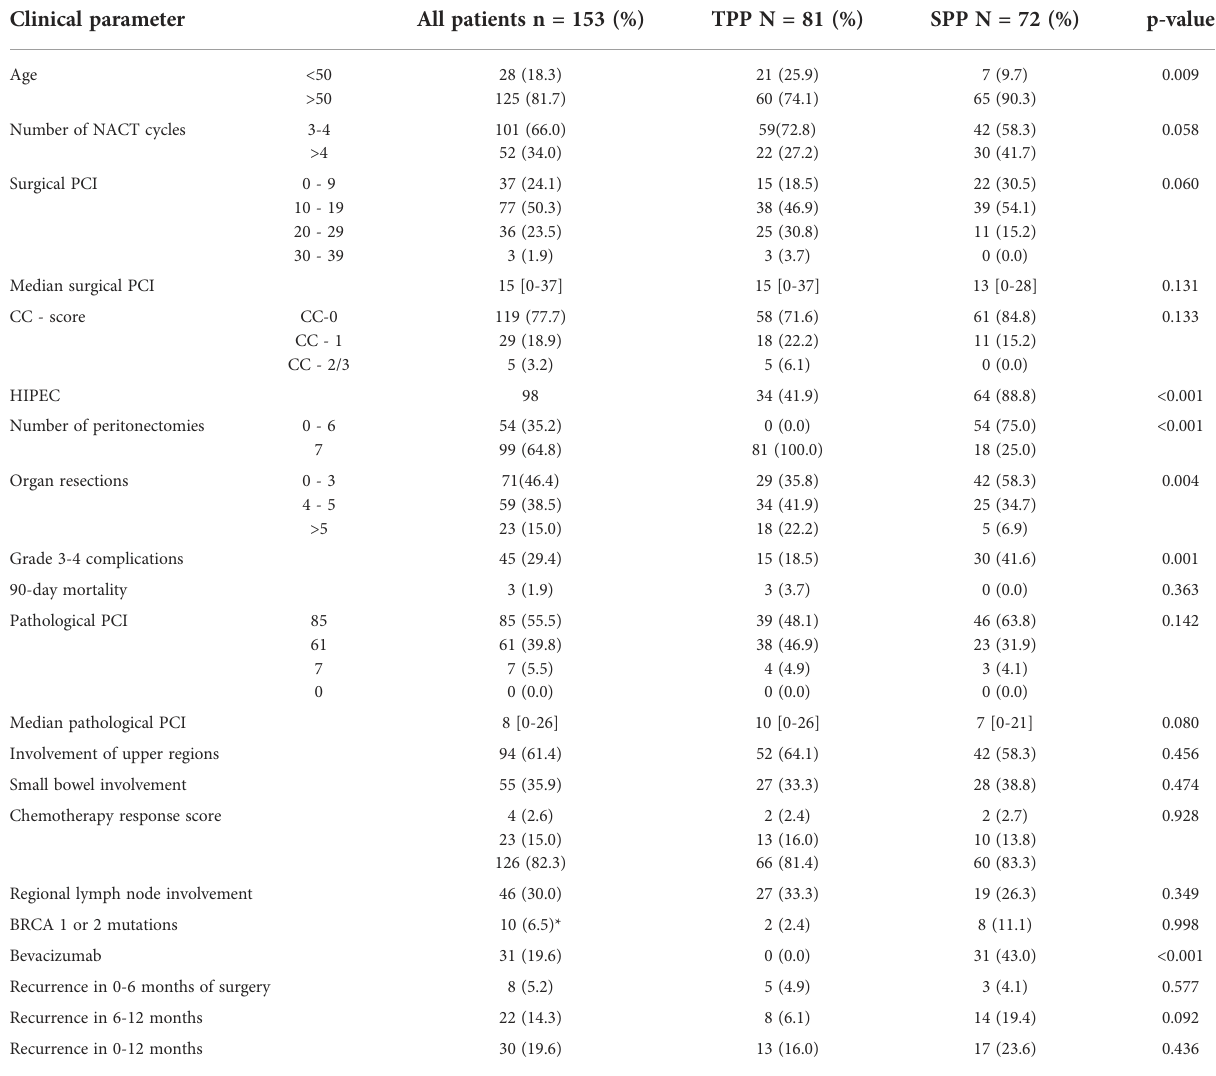
TABLE 2 Comparison of patients treated with TPP and SPP^. Clinical